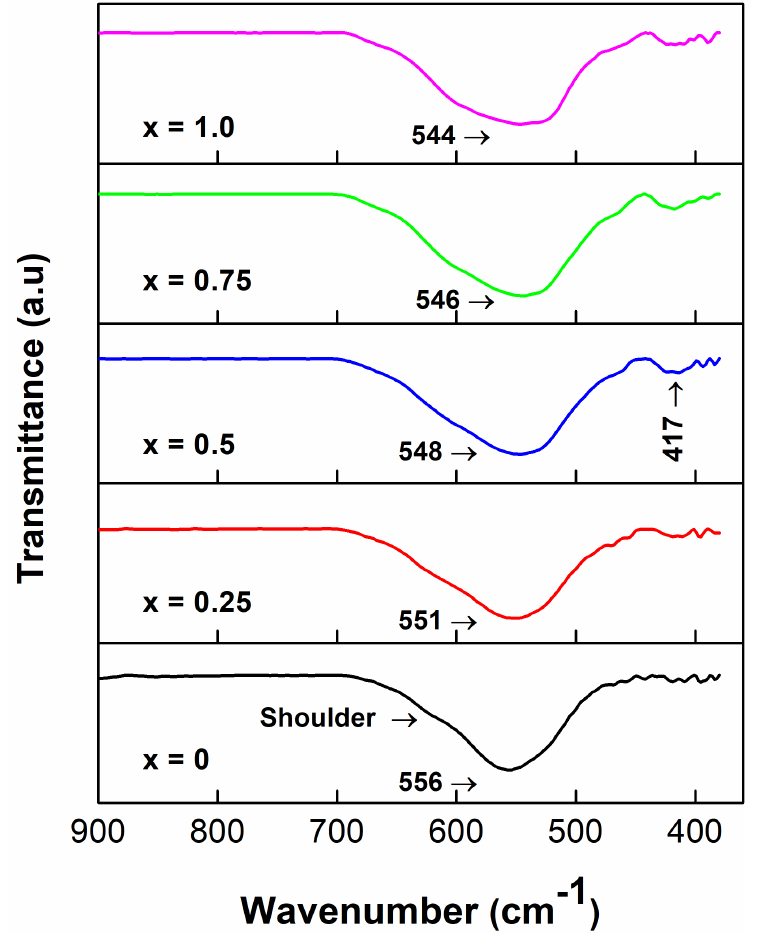
Figure 5. FT-IR spectra of the Ni x Co 1 − x Fe 2 O 4 spinel ferrites with 0 ≤ x ≤